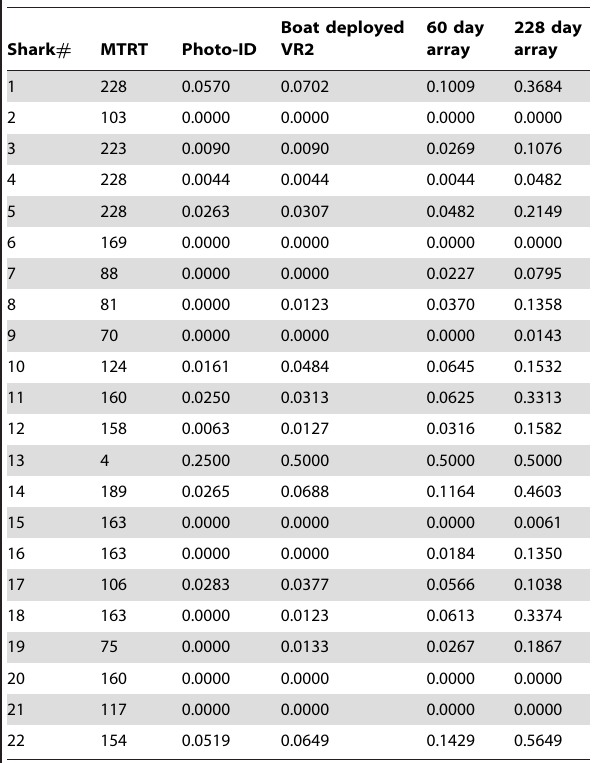
Table 1. The minimum tag retention time (MTRT) and estimates of residency by the sampling approaches (photo-ID, a VR2 acoustic listening station deployed from a boat, and an array of VR2 acoustic listening stations from 60 days of sampling, and the full array dataset for the entire 228 day study period) during the sampling period ( i.e. 3 rd April to 16 th November, 2005).